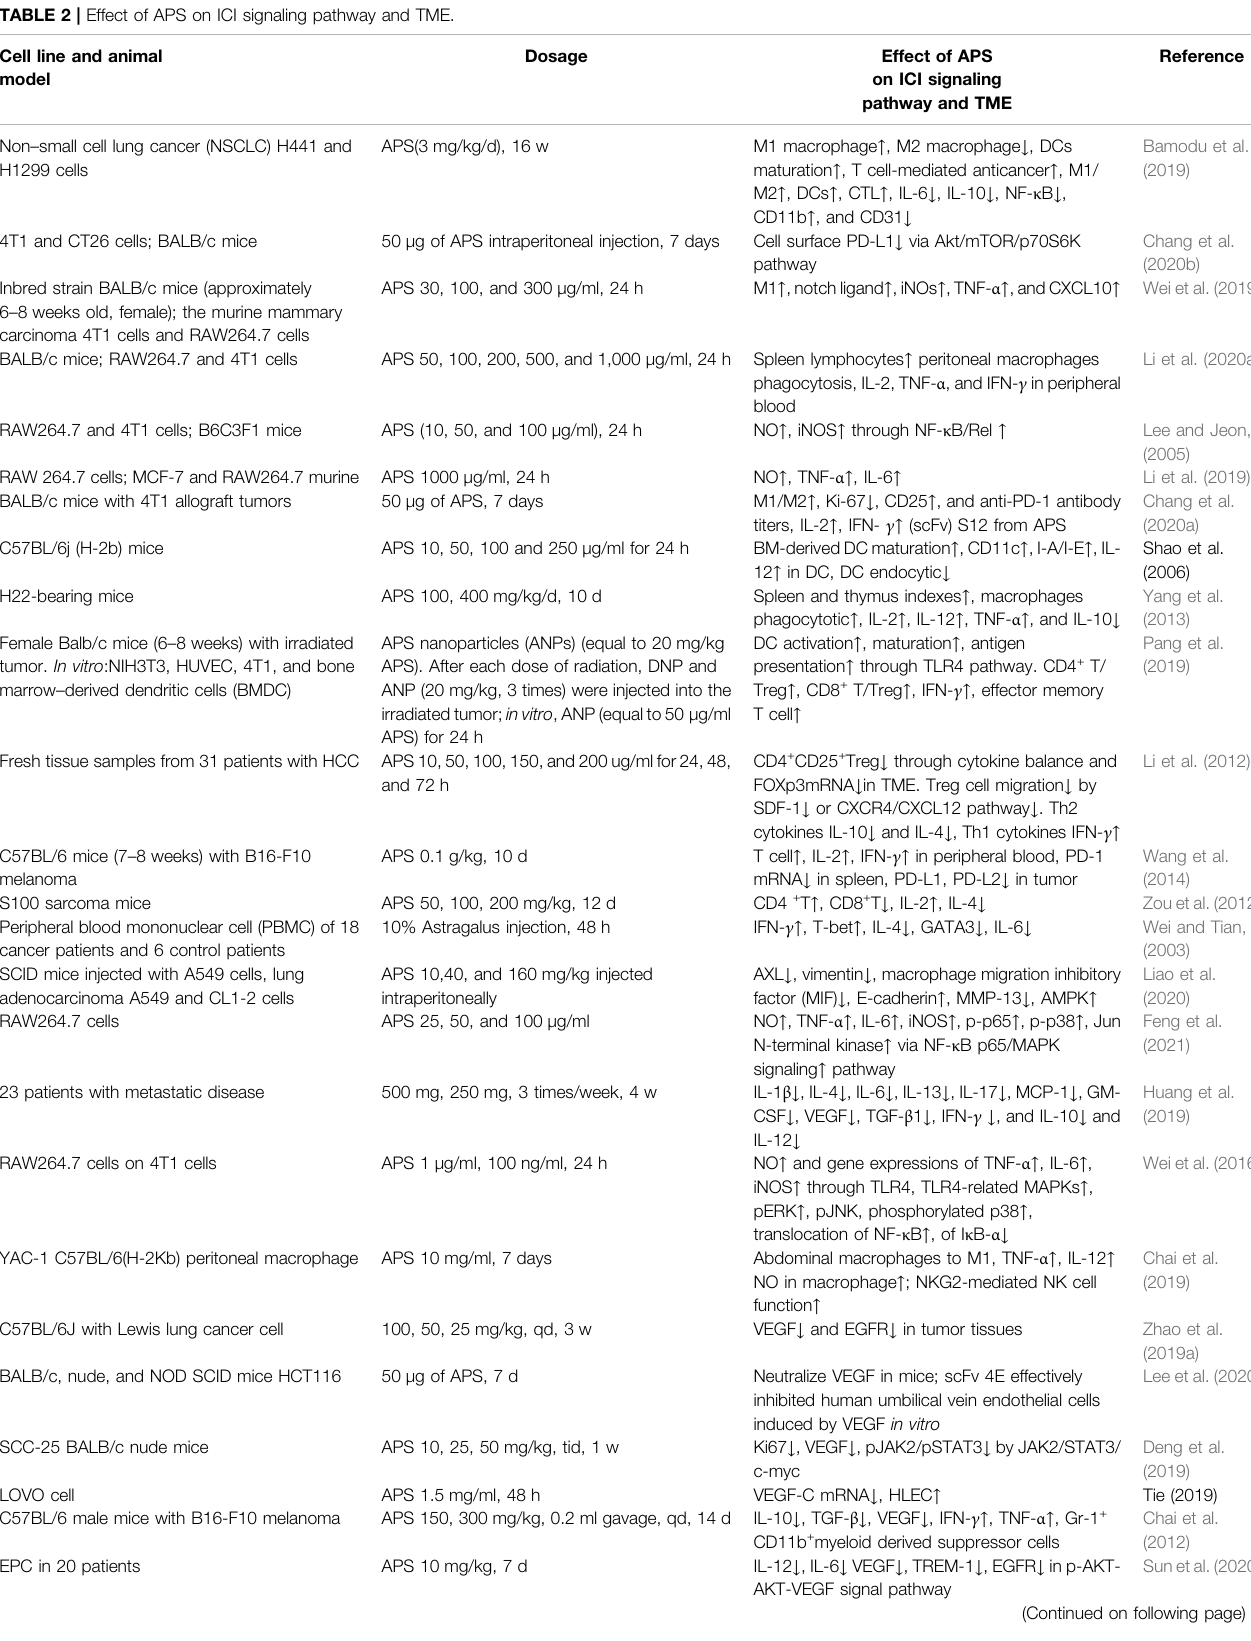
TABLE 2 | Effect of APS on ICI signaling pathway and